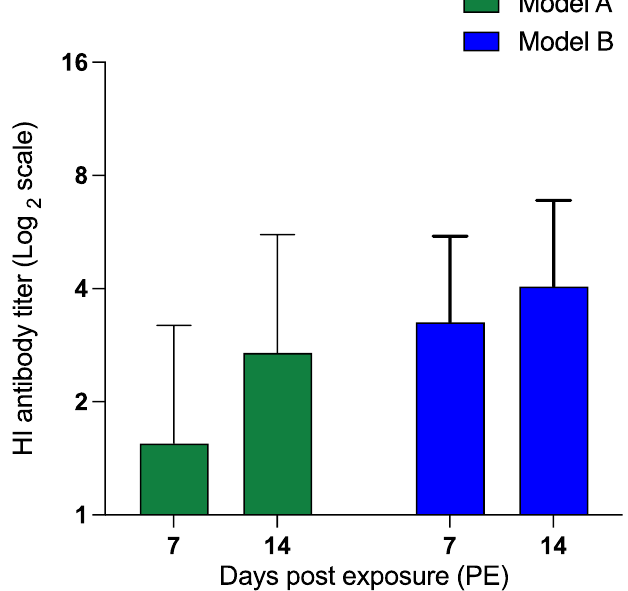
Figure 5. Serum HI antibody titers against H9N2 AIV in exposed chickens. On day fourteen of age, exposed chickens were exposed to contaminated feces from H9N2 AIV-infected chickens (model A) or experimentally spiked feces (model B) or PBS (control) ( n = 10/group). Serum was collected on days 7 and 14 PE. The HI titers were first observed on day 7 PE. The PBS+ unchallenged chickens remained negative at both time points.